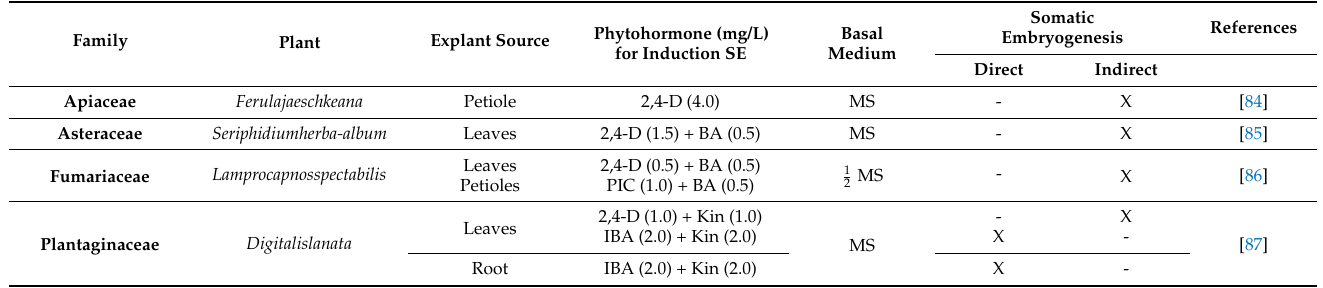
Table 2. Micropropagation of medicinal plants by somatic embryogenesis